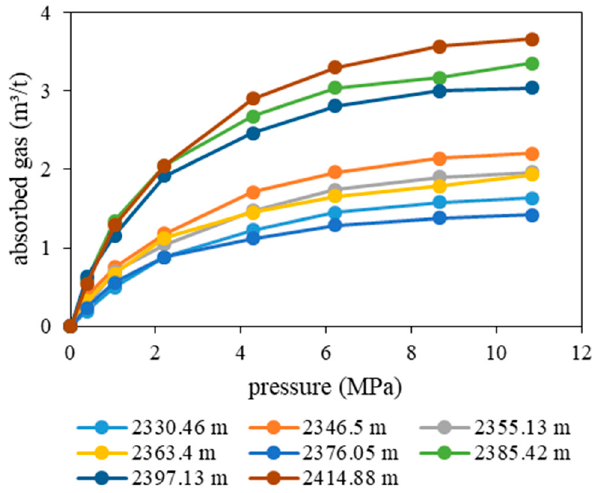
Figure 11. Methane absorption versus pressure of Wufeng-Longmaxi Formation in Well A. Table 5. Gas content data of Wufeng-Longmaxi Formation in Well A.